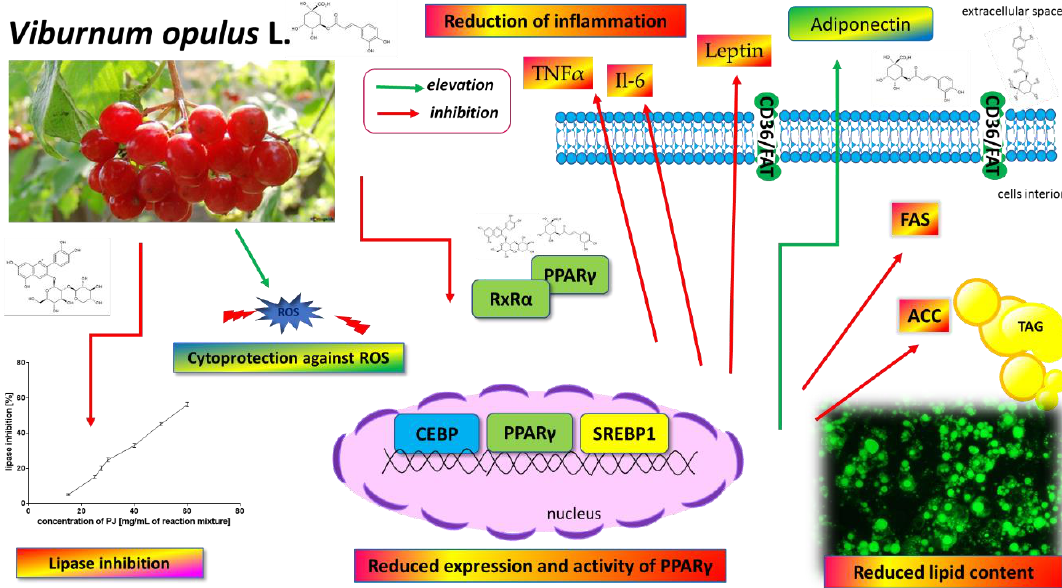
Figure 14. V. opulus juice phenolic compounds as modulators of lipids metabolism—the proposed mechanism of action. V. opulus downregulates the adipogenesis of 3T3-L1 cells, decreases the expression and activity of the PPARγ nuclear receptor as well as PPARγ-regulated proteins (i.e., fatty acid synthase (FAS), acetyl-CoA carboxylase (ACC)), diminishes the release of inflammatory cytokines and leptin, possesses cytoprotective activity against ROS generation and increases adiponectin secretion. V. opulus inhibits pancreatic-lipase and limits fatty acid release from the food matrix.